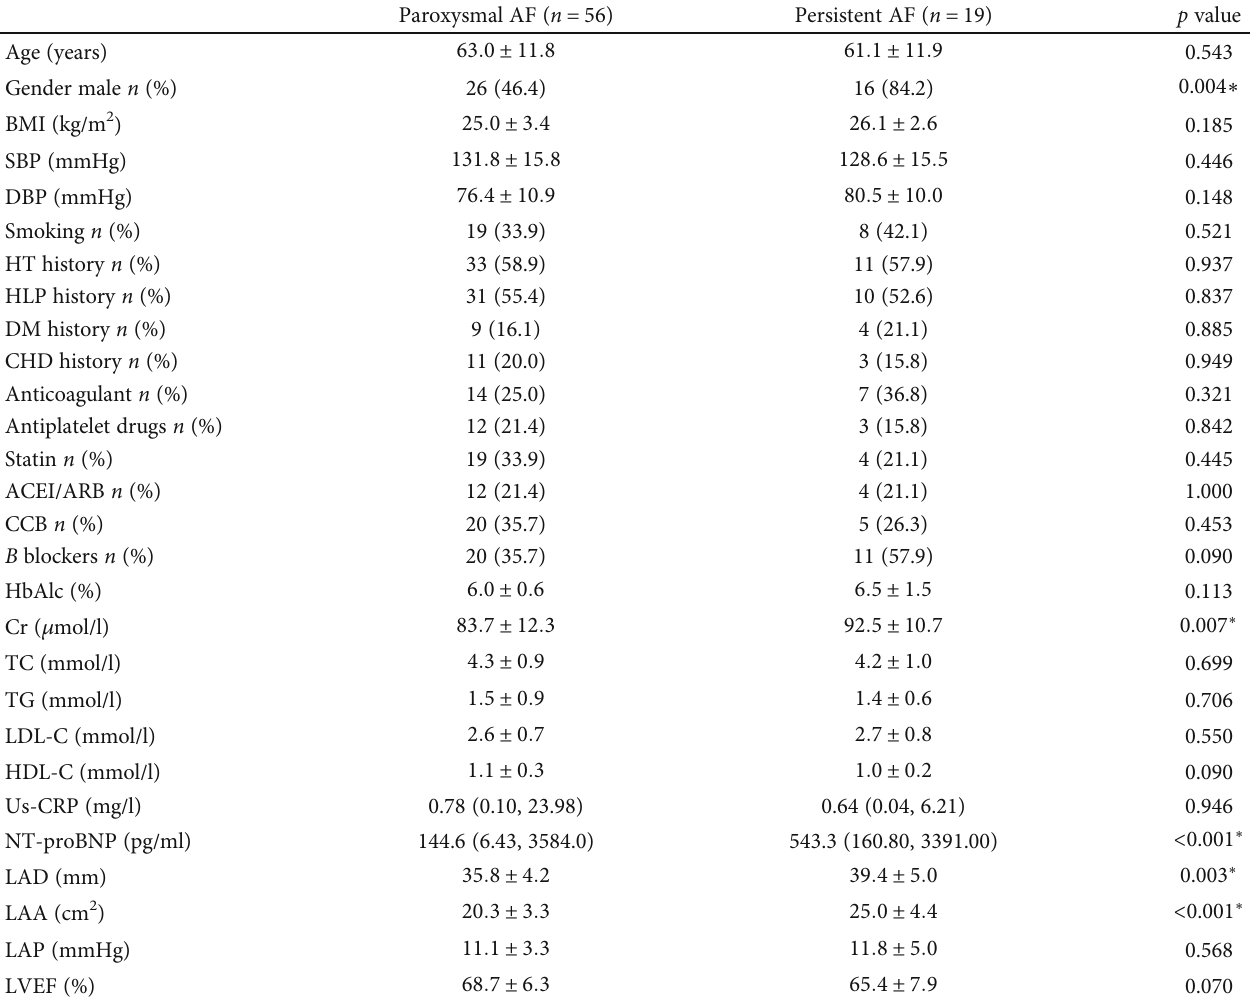
Table 2: Clinical and biochemical characteristics of AF